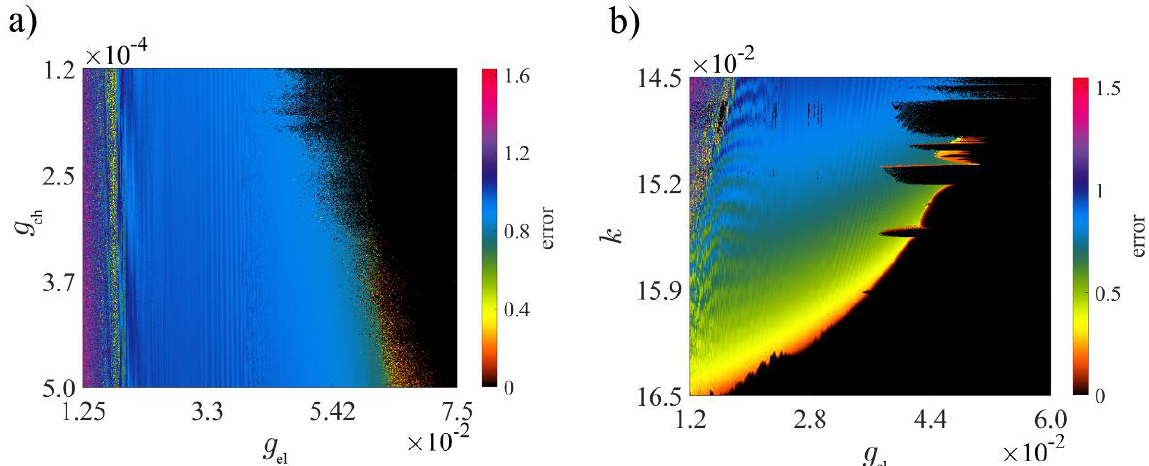
Figure 7. The 2D synchronization error of two 3D-MCMs in the ( a ) 𝑔 𝑒𝑙 – 𝑔 𝑐ℎ plane when 𝑘 = 0.145 , and ( b ) 𝑔 𝑒𝑙 – 𝑘 plane when 𝑔 𝑐ℎ = 0.00012 . The other system parameters are set, as mentioned in Table 3, with initial conditions (𝑥 1 (0), 𝑦 1 (0), 𝜙 1 (0)) = (1.0, 0.8, 0.2) and (𝑥 2 (0), 𝑦 2 (0), 𝜙 2 (0)) = (0.5, 0.2, 0.3) .